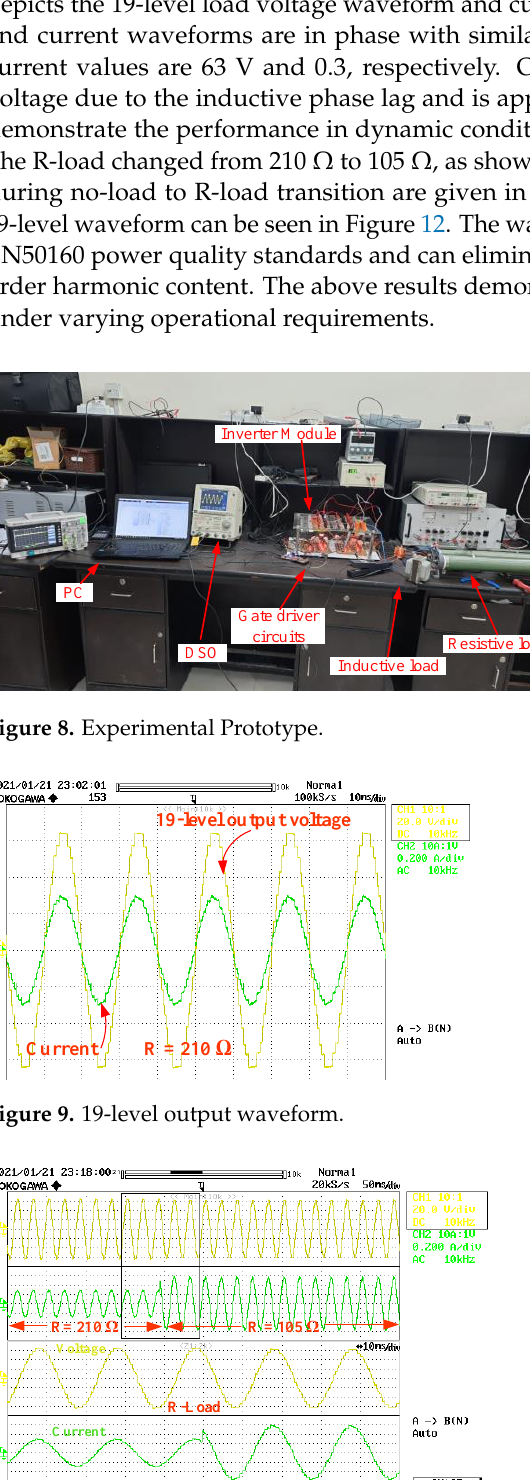
Figure 7. Switch stresses during simulation ( a ) Voltage Stress ( b ) Current Stress.